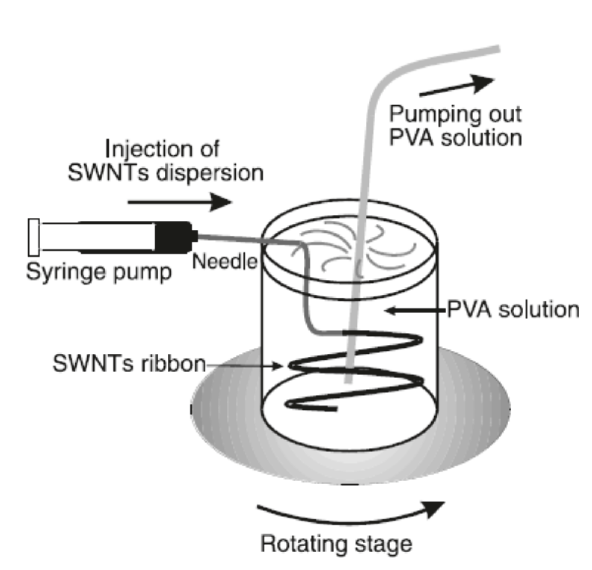
Figure6:Schematicofwetspinningapparatussetup[29].Reprinted from [29].